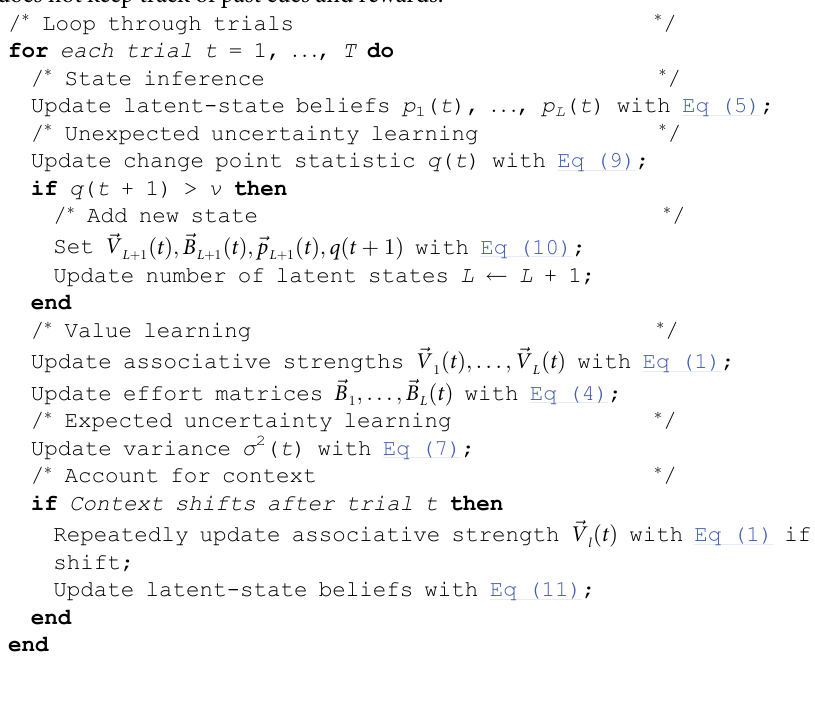
Algorithm 1 : Proposed model of latent-state learning which updates variables online , i.e. does not keep track of past cues and